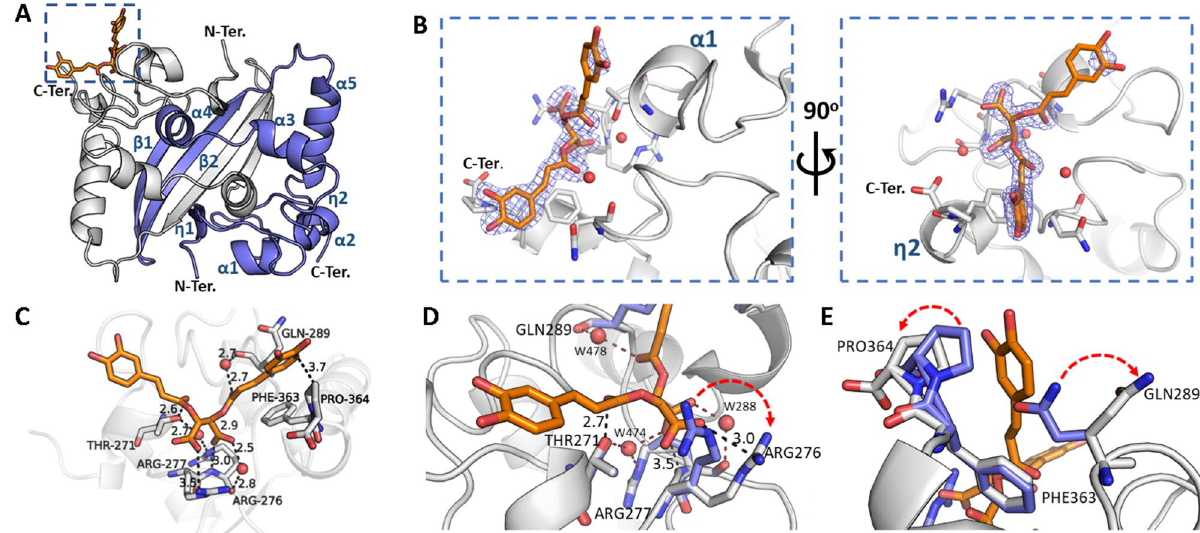
Figure 4. The crystal structure of SARS-CoV-2 N protein CTD binding chicoric acid (CA) reveals a network of polar contacts and structural readjustments to accommodate the symmetric ligand in the CA-N protein binding site. ( A ) Cartoon representation of the N protein CTD dimer crystal structure depicting its secondary structure elements (in blue), including two 3 10 (η) helices, five α-helices and two antiparallel β-strands and the CA binding site (inset highlighted by the blue dashed square). ( B ) Detailed CA-binding site from the inset of panel ( A ). The CA molecule is represented as sticks (orange) with its electron-density map in blue. CA binds to a shallow pocket formed between α-helices 1–2 and η-helix 2, close to the C-terminus (C-Ter). ( C ) CA atomic interactions with the N protein residues. The CA carboxyl groups are at ideal distances to engage electrostatic interactions and hydrogen bonds with Arg276 side chain (NH1 atom), Arg277 main chain amine and a structural water molecule (W288) stabilized by Arg276 NH2. Thr271 and Gln289 can further position hydrogen bond donors (Thr271O γ and a structural water molecule, W478, stabilized by the Gln289 carbonyl) to engage a symmetric interaction with the carbonyl groups from both caffeoyl units of CA. One of the catechol motifs of CA is well accommodated near the C-terminal Pro364, showing a well-defined electron density (vide panel B ). ( D , E ) Superposition of the CA-binding site in the native N protein CTD (blue sticks, PDB ID 7UXX) and CA-N protein CTD complex (grey sticks (PDB ID 7UXZ) highlighting structural readjustments induced by CA binding (highlighted by red arrows). Figures were generated with Pymol (Schroedinger Inc.). Polar contacts are indicated by dashed lines with the measured distances in Angstroms. Oxygen atoms are shown in red, nitrogen atoms in blue. Water molecules are represented as red